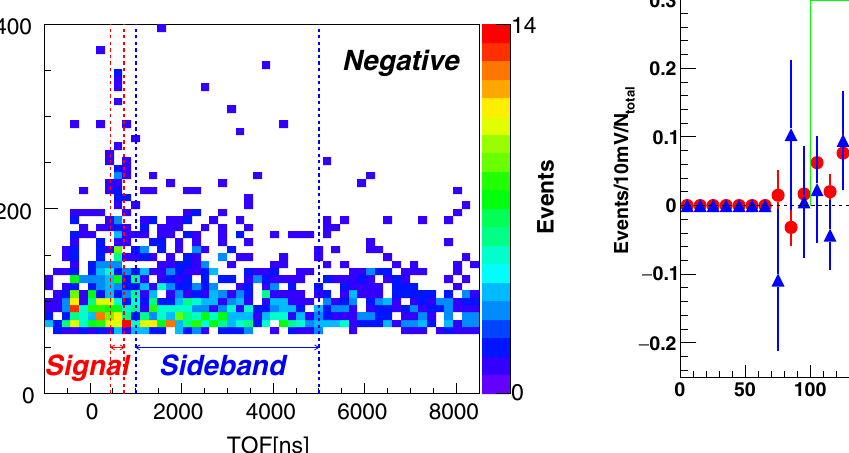
FIG. 7. Comparison of subtracted pulse-height distributions for decelerated μ þ ’ s and Mu − ions. The histograms were normalized based on the number of total events. The green arrow indicates the threshold level applied to obtain ToF spectra shown in Fig.